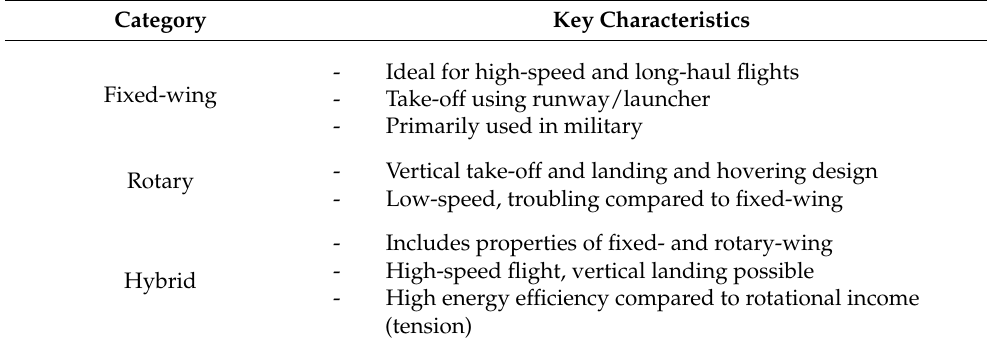
Table 1. UAM classification by aircraft type, KIAST.